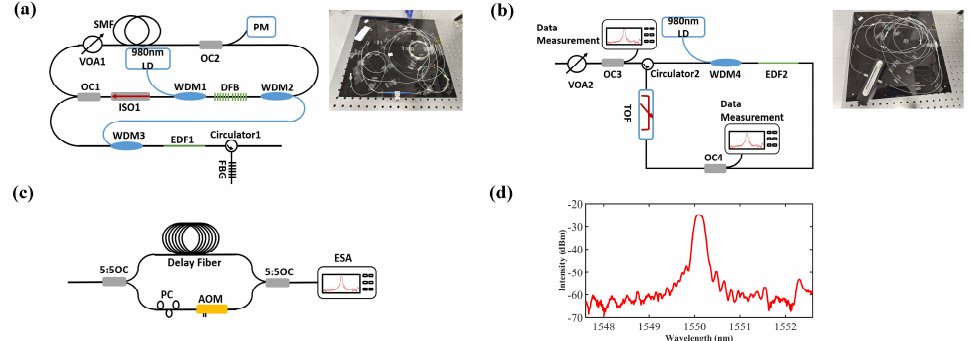
Figure 1. Experimental setup of ( a ) DFB with SIL, ( b ) BEFL, and ( c ) DSHI. ( d ) Reflection spectrum of the FBG. PM: power meter; PC: polarization controller; AOM: acoustic optic modulator. Insets: the photographs of the experiment setup.